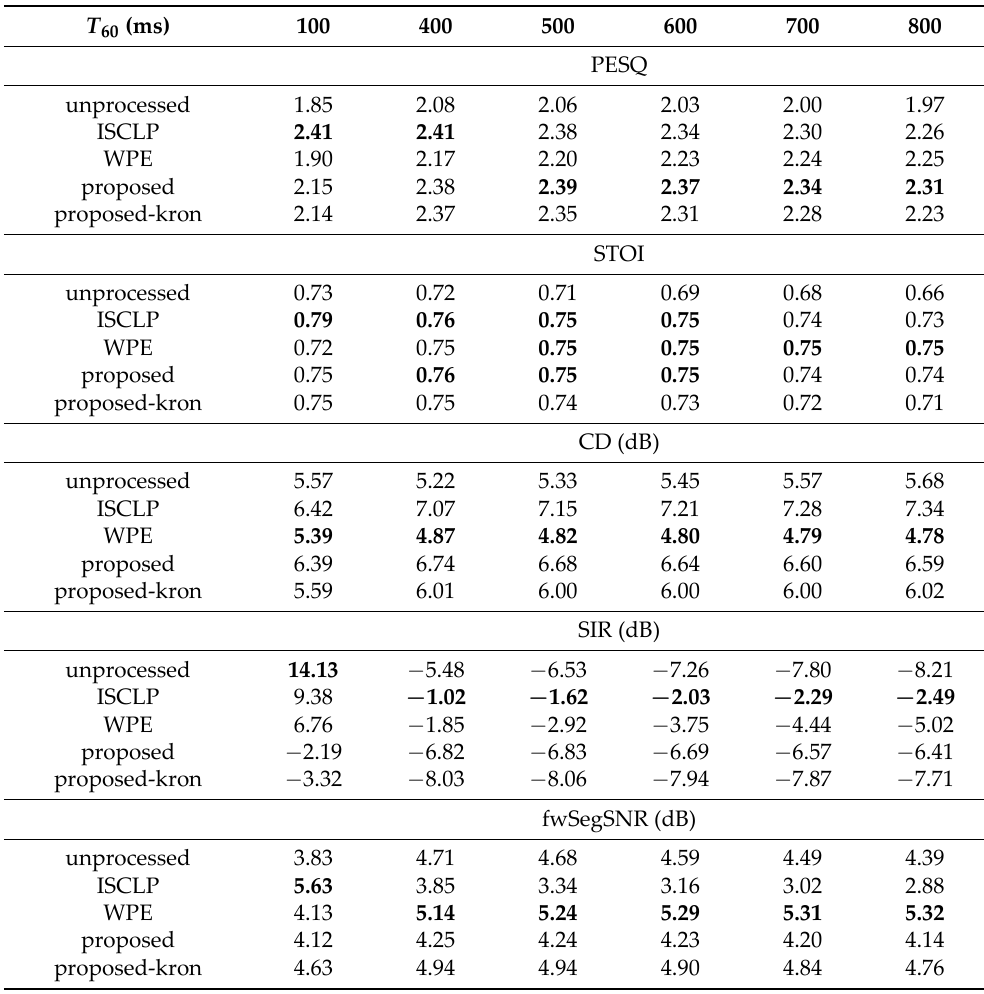
Table 3. Comparison of the test results at 5 dB for babble noise. (The bold in the table indicates the best result).